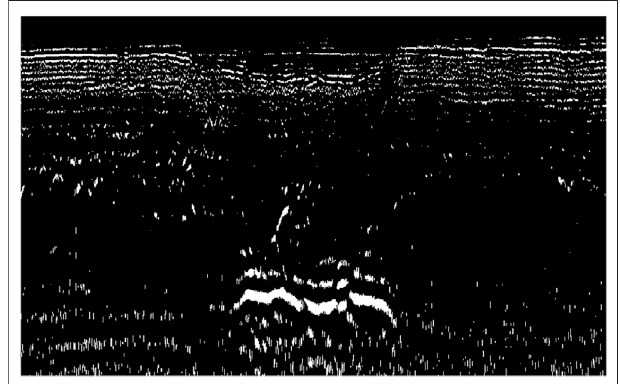
FIGURE 3 | Binarization image (black corresponds to "0," and white corresponds to